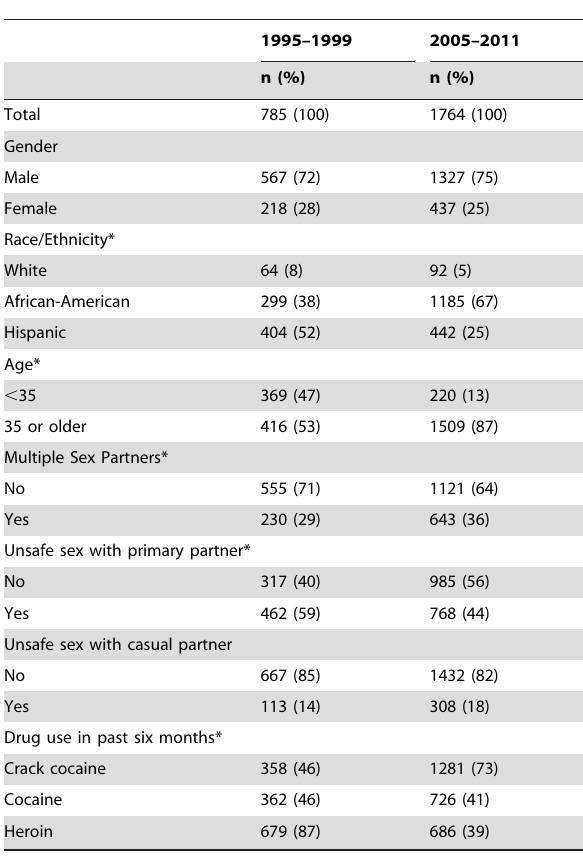
# Significant difference by chi square test (comparing same row across time periods). *Significant difference by chi square test (largest subgroup compared to all others within time period).